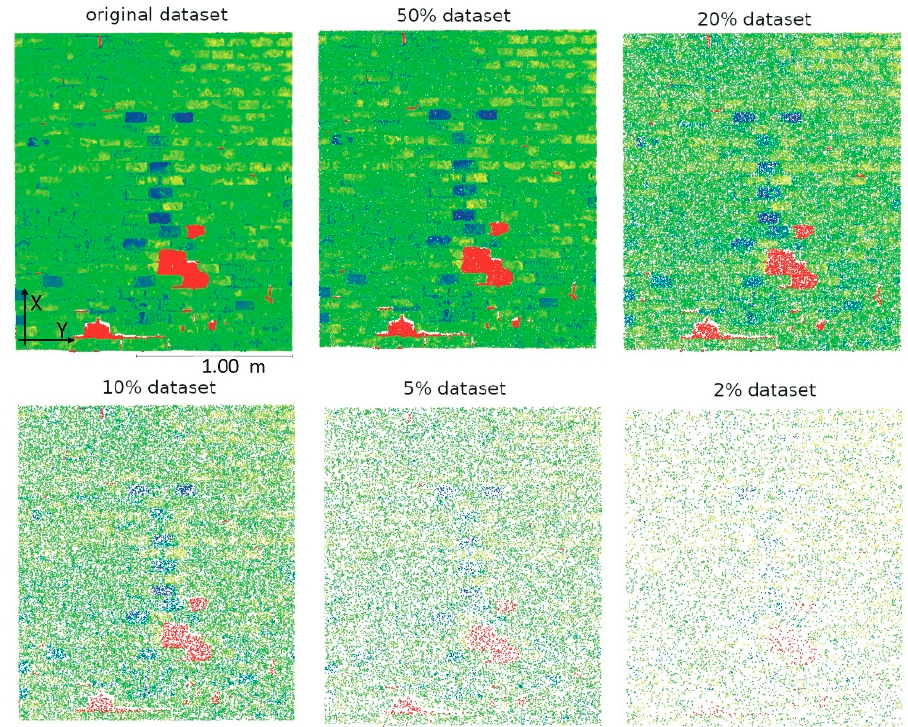
Figure 8. Damage mapping results in a brick wall using the random method.